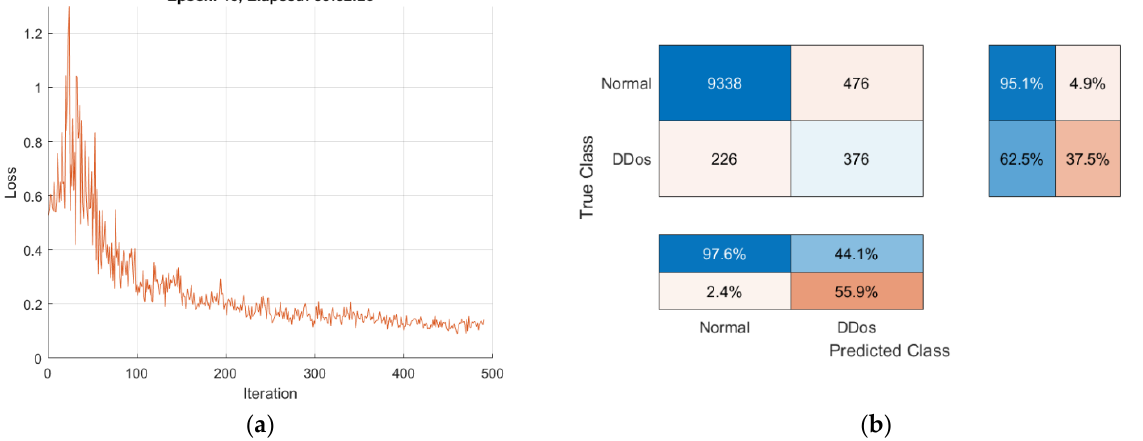
Figure 17. Training progress and performance of the FL method: ( a ) loss evaluation of Local Model4; ( b ) confusion matrix of Local Model4.